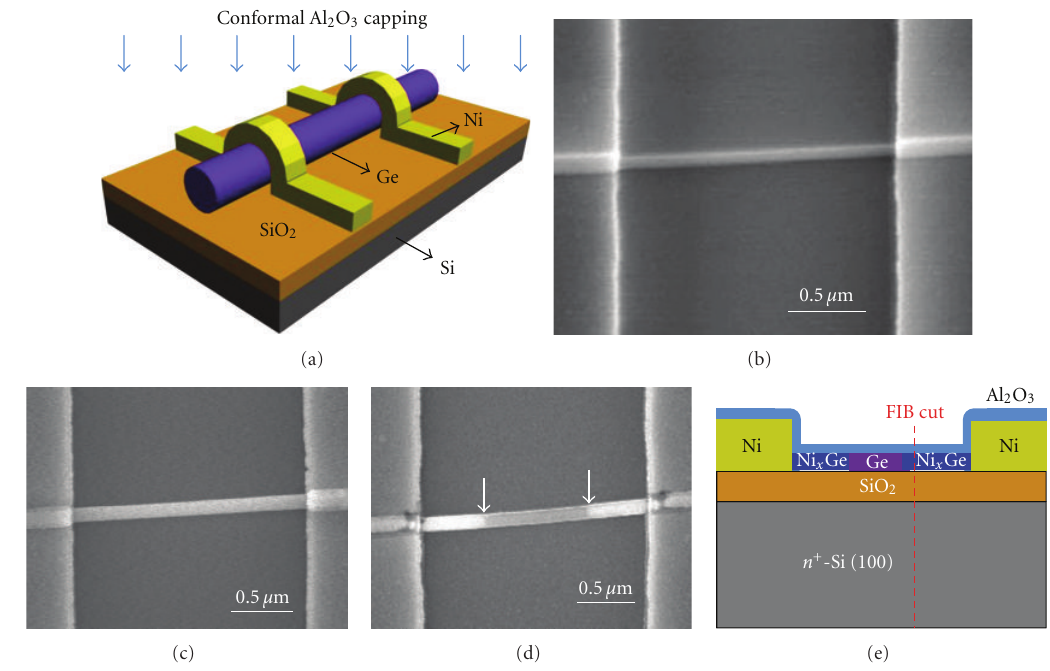
Figure 5: Formation of Ni x Ge/Ge/Ni x Ge heterostructure with the Al 2 O 3 confinement. (a) Schematic illustration of an Al 2 O 3 conformal capping on the Ge nanowire device by ALD. (b) SEM image of the as-fabricated Ge nanowire device with EBL-defined Ni electrodes. (c) SEM image of the Ge nanowire device after a conformal capping of 20nm thick Al 2 O 3 . (d) SEM image of the Ni x Ge/Ge/Ni x Ge heterostructure after RTA at 450 ◦ C for 20s in which the length of the Ge region was easily controlled to be several hundred nanometers. The arrows indicate the growth tip of the Ni x Ge nanowire. (e) Schematic illustration showing the formation of Ni x Ge/Ge/Ni x Ge nanowire heterostructure with the Al 2 O 3 confinement. The red line indicates the position chosen for FIB to study the cross-sectional structure in Figure 6. Reproduced from